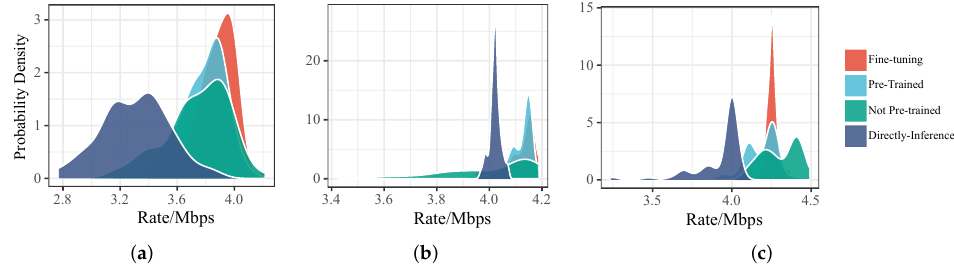
Figure 12. The probability density function for communication rate when small changes occur to the network. ( a ) PDF for communication rate when location of users changes. ( b ) PDF for communication rate when E changes. ( c ) PDF for communication rate when |V s |